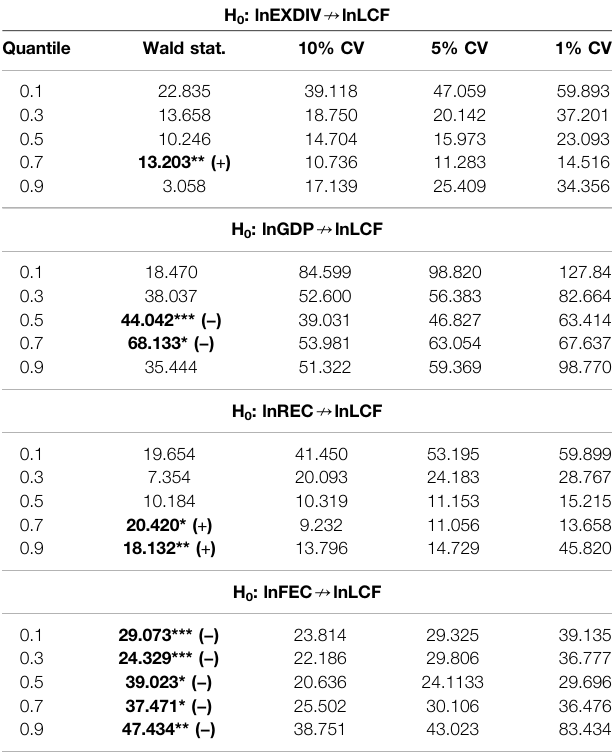
TABLE 4 | Results of Fourier quantile causality test.